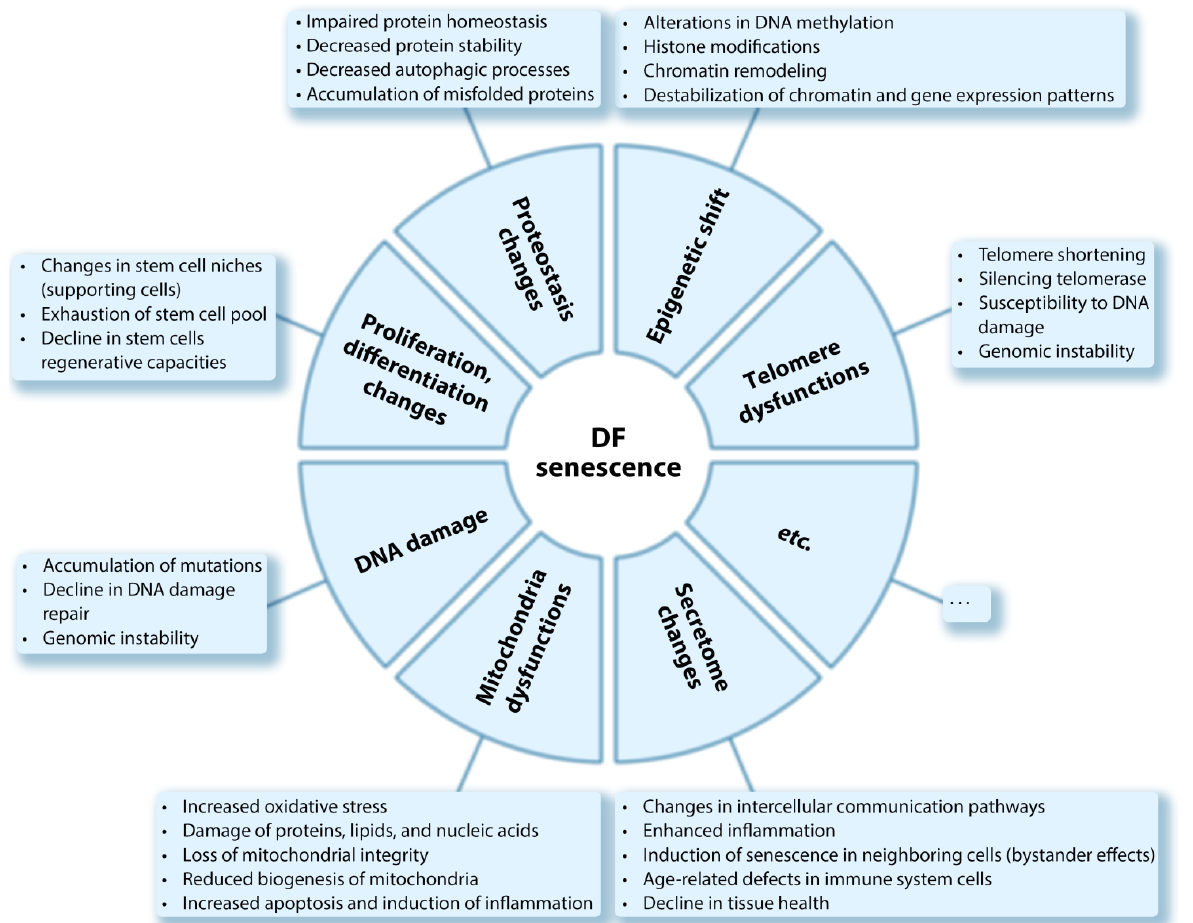
Figure 1. Characteristics of the cellular and molecular signs of cellular senescence.